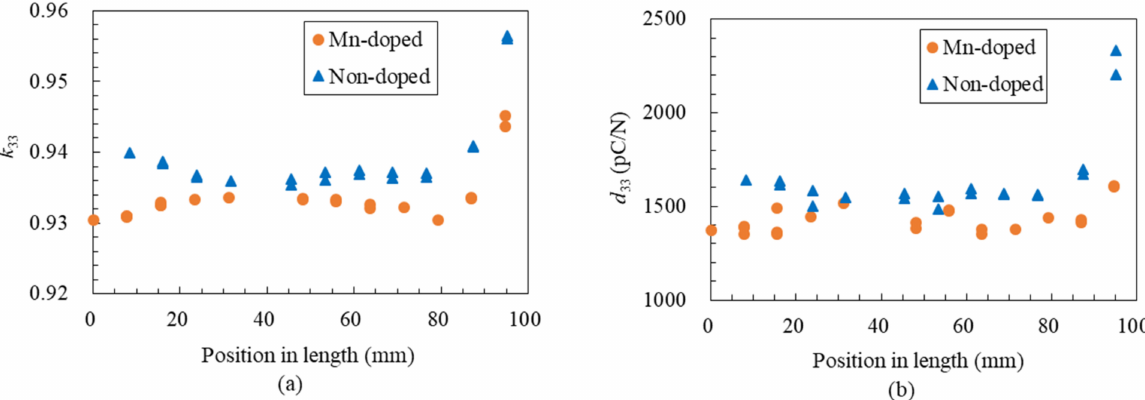
Figure 4. Distributions of ( a ) electromechanical coupling coefficients k 33 and ( b ) piezoelectric con- stants d 33 along the growth direction for Mn-doped and non-doped PIN-PMN-PT boules grown by the continuous-feeding Bridgman method.